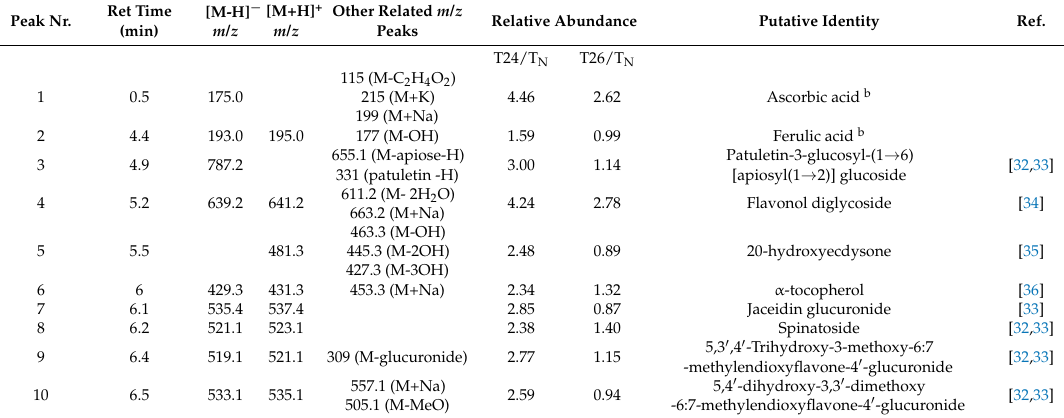
Table 1. Liquid chromatography-mass spectrometry analysis: principal identified peaks and relative abundance a . − Other Related m/z Peak Nr. Ret Time (min) [M-H] Peaks Relative Abundance Putative Identity m/z